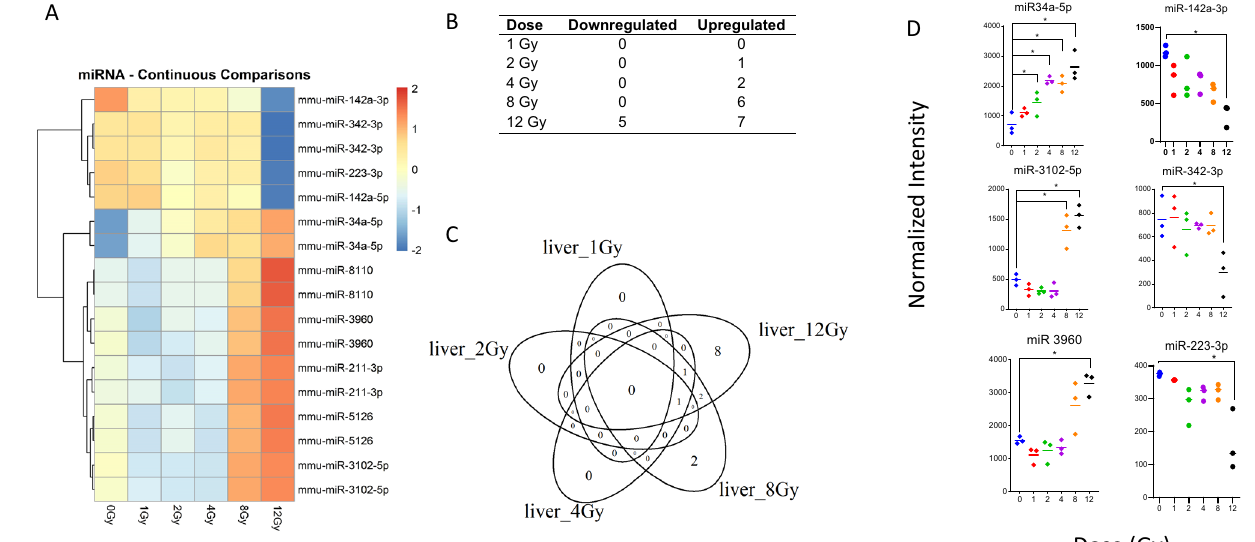
Figure 4. Radiation-induced microRNA expression profiles in mouse liver tissue. Microarray analysis was performed for all samples, and a linear model was fit to each miRNA probe to assess differential expression of irradiated samples compared to controls. Criteria of |log 2 FC|> 1 and B-H p value < 0.05 relative to controls were used to determine significance and differential expression. ( A ) Heatmap displays expression patterns, represented by z-score, of all differentially expressed miRNAs across all doses and controls. ( B ) The number of down-regulated versus up-regulated miRNAs at each dose are shown in the table. ( C ) Venn diagram shows dose distribution and overlap of differentially expressed miRNAs across all doses. ( D ) Examples of significant linearly up- and down-regulated miRNAs are shown to display the dose response to radiation in liver tissue samples. Asterisk (*) indicates statistical significance.